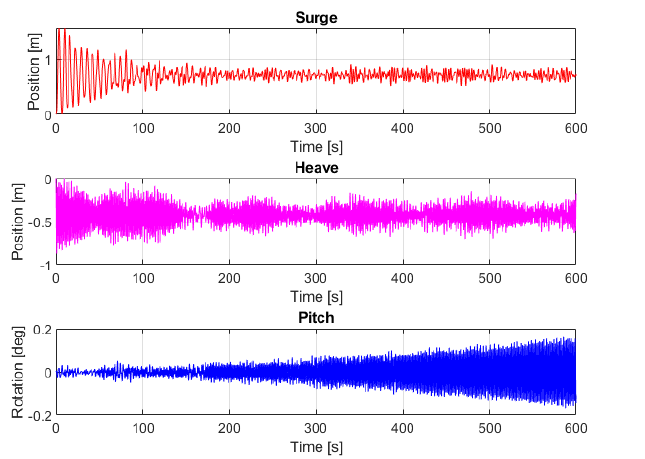
Figure 13. Surge, heave and pitch for Hs = 0.375 m, Te = 3.625 s and V = 8 m/s.